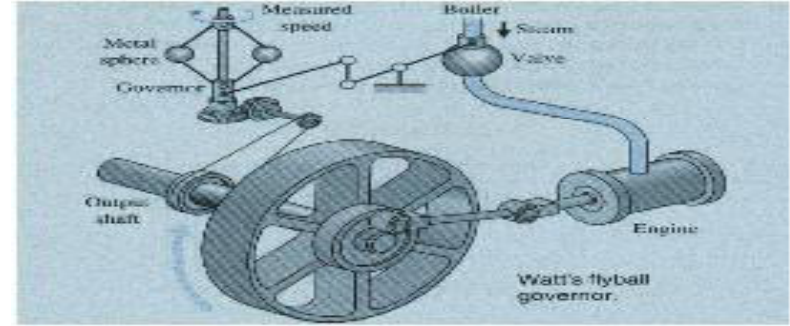
Figure 1: watt invented the steam engine